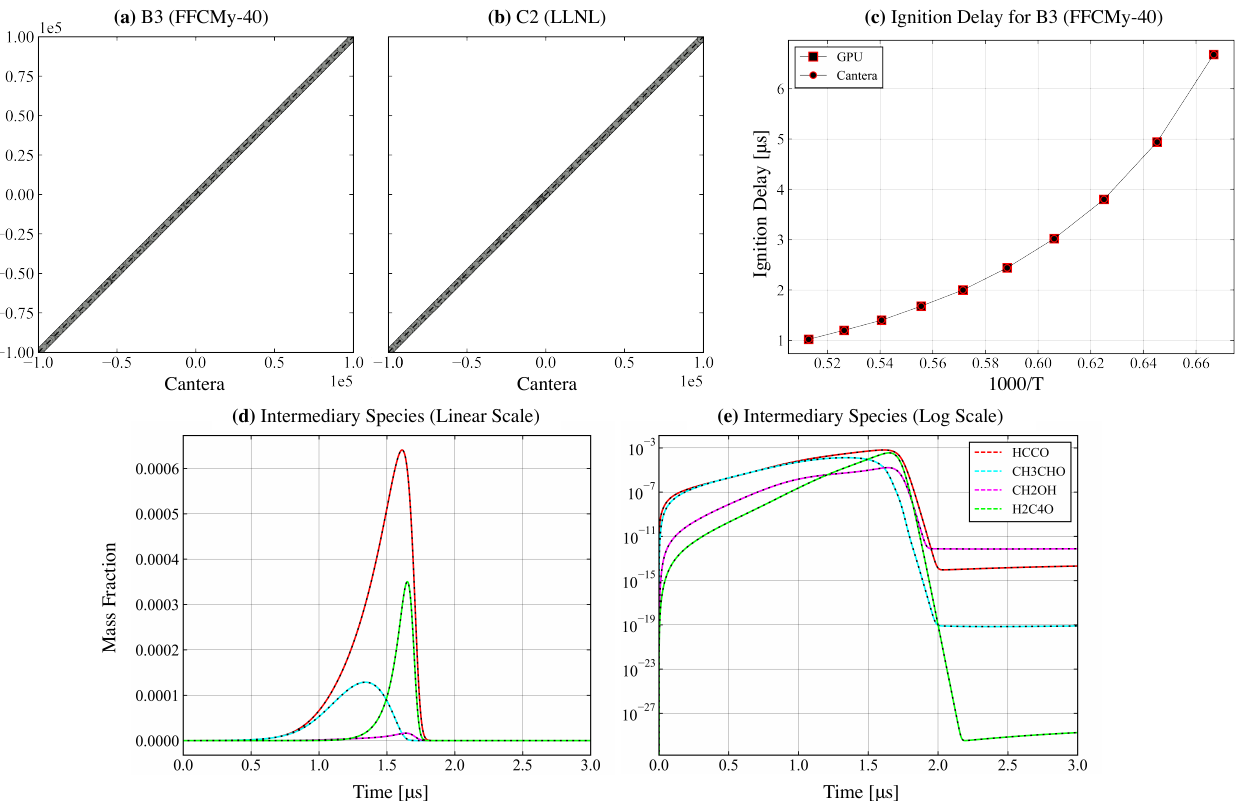
Figure A2. ( a ) Scatter plots comparing GPU ( y -axis) and CPU-based Cantera ( x -axis) species source term values for mechanism B3. Dashed black line represents the exact solution. ( b ) Same as ( a ), but for mechanism C2. ( c ) Constant-volume ignition delay times for mechanism B3 using the GPU formulation (squares) and Cantera (circles). For the initial condition, an ethylene-air mixture was used at an equivalence ratio of unity with an initial pressure of 10 atm. ( d ) Intermediary species profiles from a constant-volume ignition simulation (same conditions as specified in ( c ) with initial temperature of 1800 K) using the GPU implementation (dashed colors) and Cantera (solid black). ( e ) Same as ( d ), but in logarithmic scale on the y